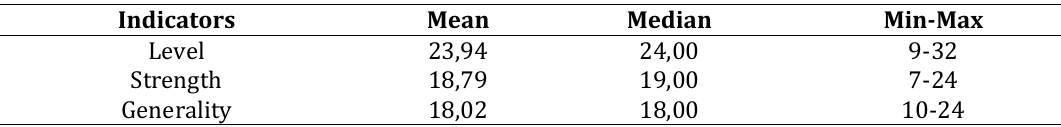
The average value of self-efficacy indicators for nursing professional education students at the Faculty of Nursing, University of Jember (n = 236